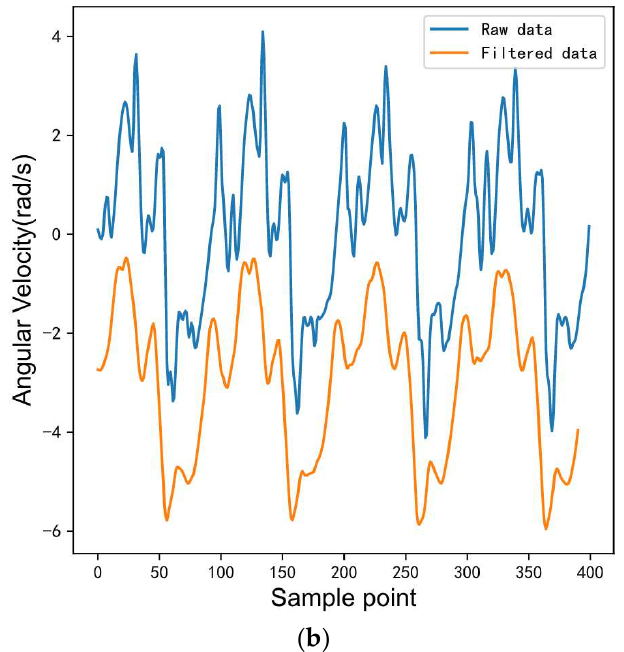
Figure 2. Comparison between raw and filtered IMU data. ( a ) Comparison between raw and filtered 3D acceleration data. ( b ) Comparison between raw and filtered 3D angular velocity data.